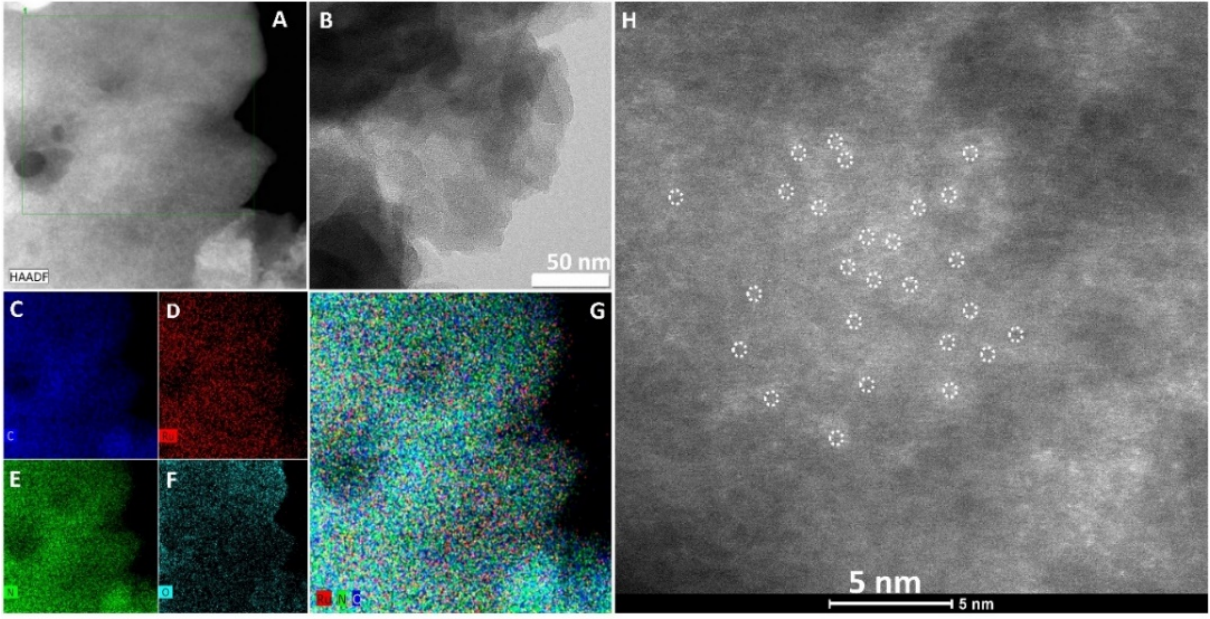
Figure 2. HR-TEM analysis of SRu-mC 3 N 4 : ( A ) HAADF-STEM elemental mapping images showing O, N, Ru, and C individually ( C – F ) and ( G ) Ru, N, and C together (scale: 40 nm); ( B ) TEM image at 50 nm; and ( H ) HR-TEM image at 5 nm exhibiting the ruthenium single atom existence over mC 3 N 4 support.